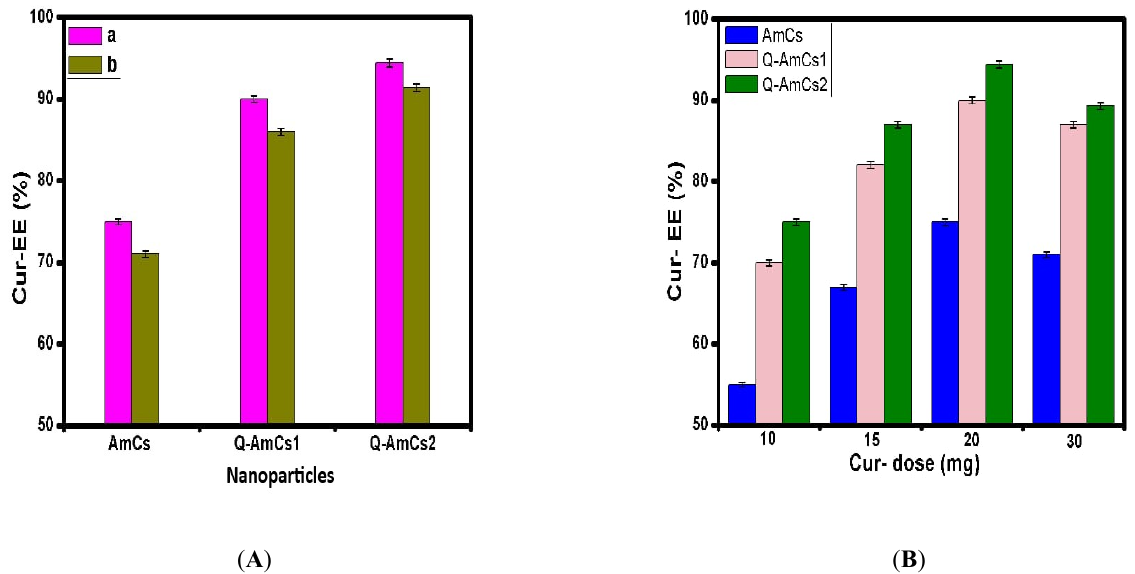
Figure 4. Encapsulation efficiency (EE%) values of the Cur-loaded NPs at ( A ) different polymer/TPP ratios [(a) 5:1and (b) 10:1], and ( B ) at different initial Cur-dose. All measurements were performed in triplicates ( n = 3), and the values were expressed as mean + standard deviation (±SD).